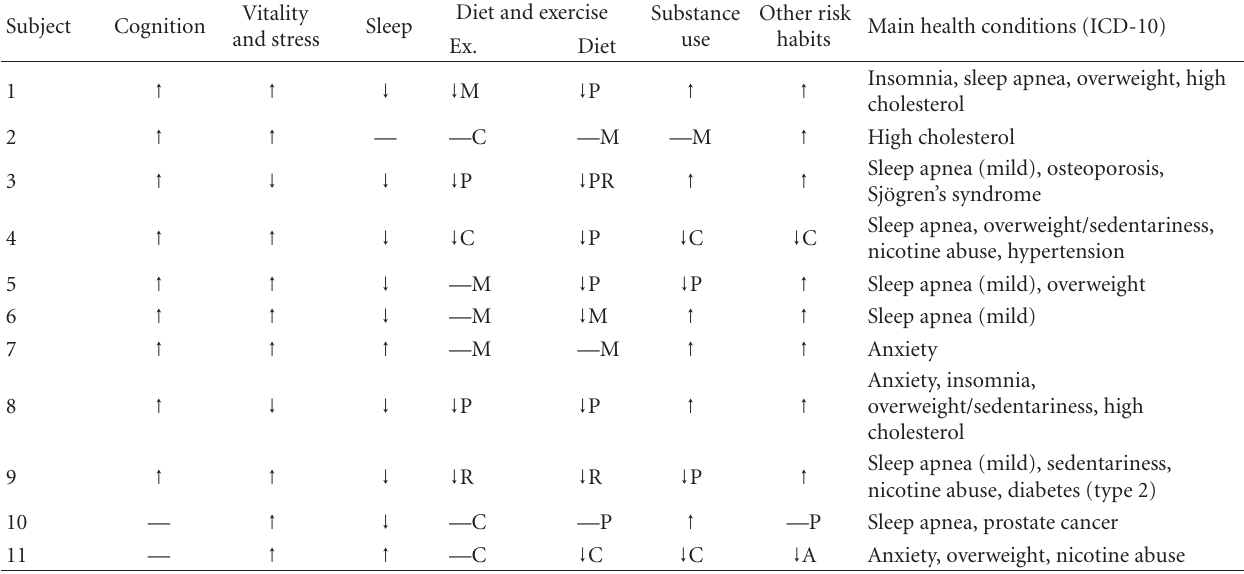
Table 2: eVITAL lifestyle profile related to health habits and the Prochaska stage of change in 11